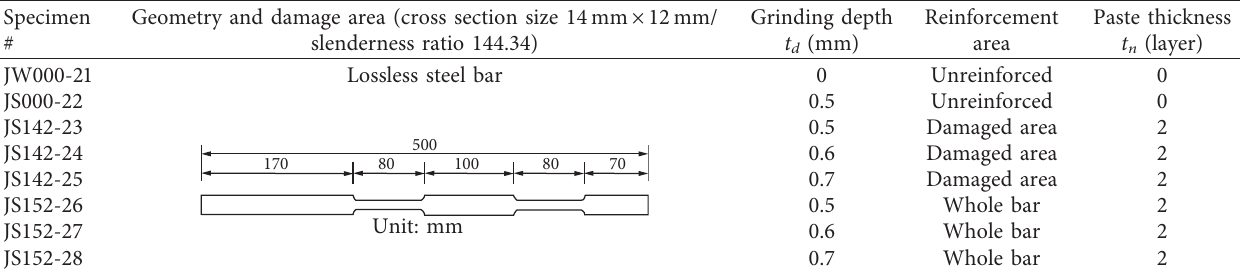
Table 2: Damage and reinforcement of steel specimens in Group